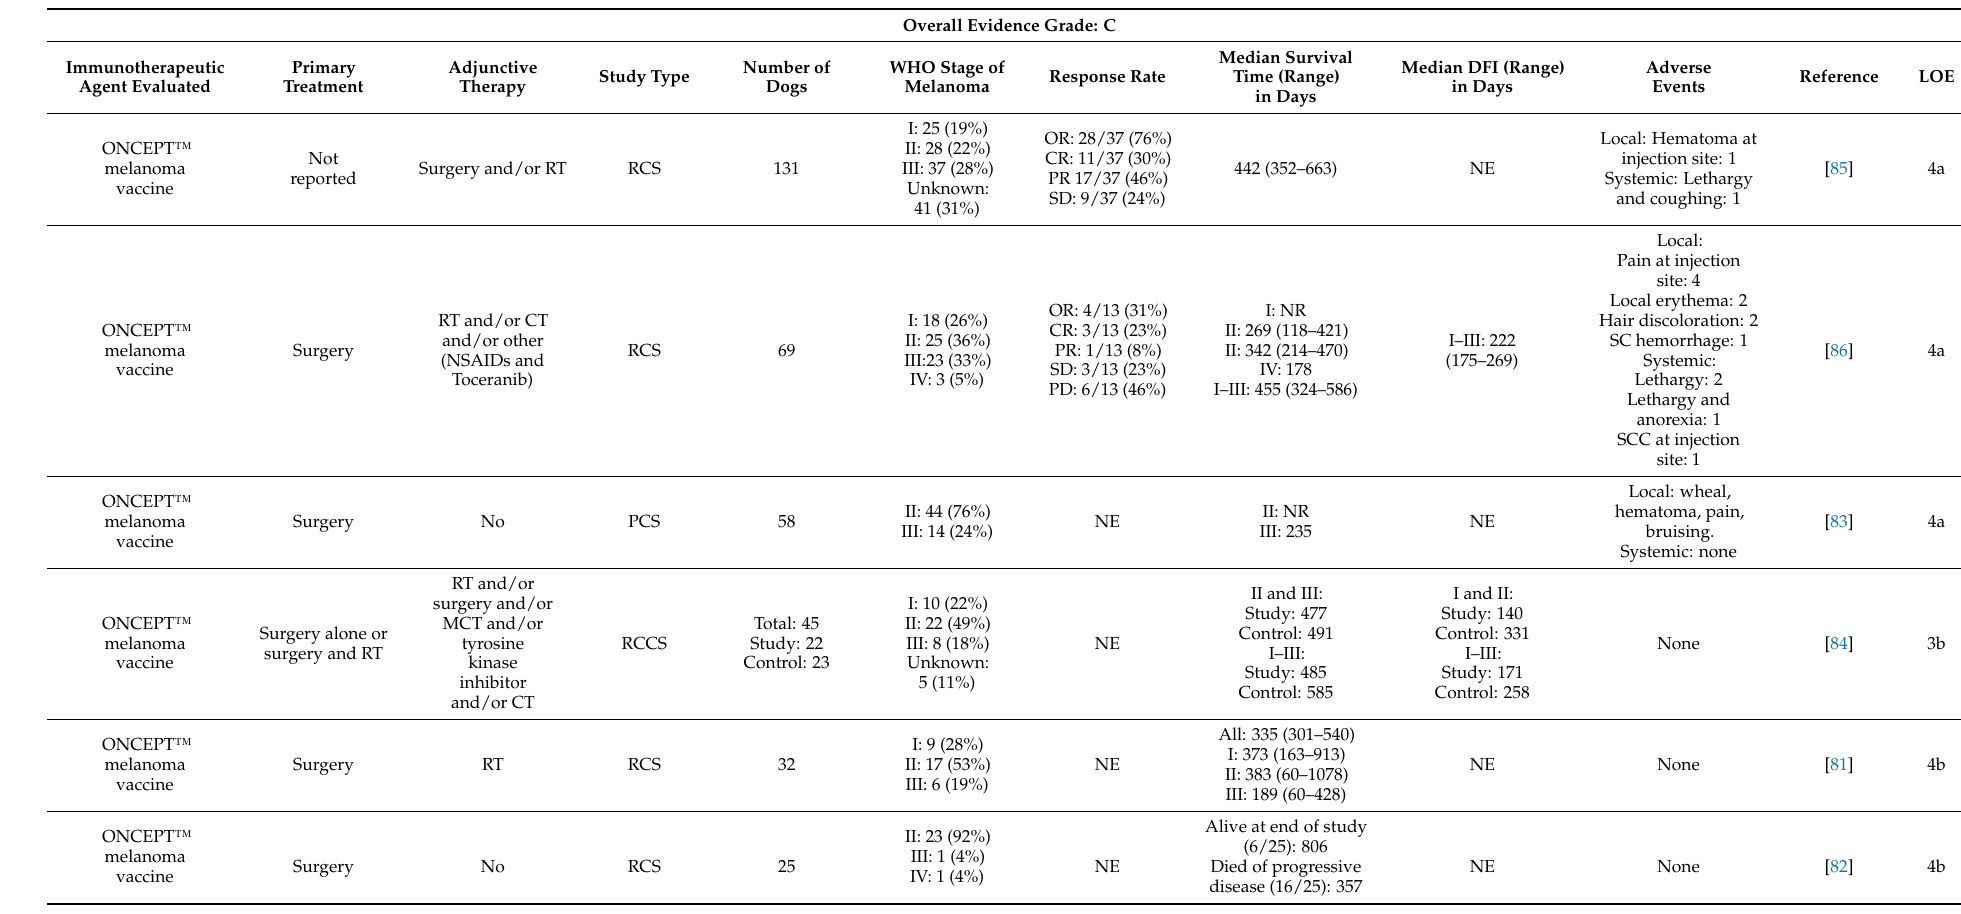
Table 9. Summary of vaccination studies evaluating effectivity in oral malignant melanoma. Overall Evidence Grade: